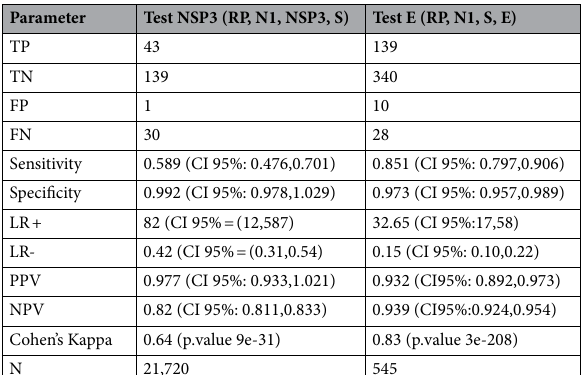
Table 1. Test performance. A total of 762 samples were tested by end-point PCR to determine the presence of SARS-CoV-2. The samples were previously tested by the gold standard RT-qPCR. 217 samples were used for test NSP3, and 545 samples were used for test E, respectively. 4 and 10 samples, respectively, were diagnosed as inconclusive and excluded from the